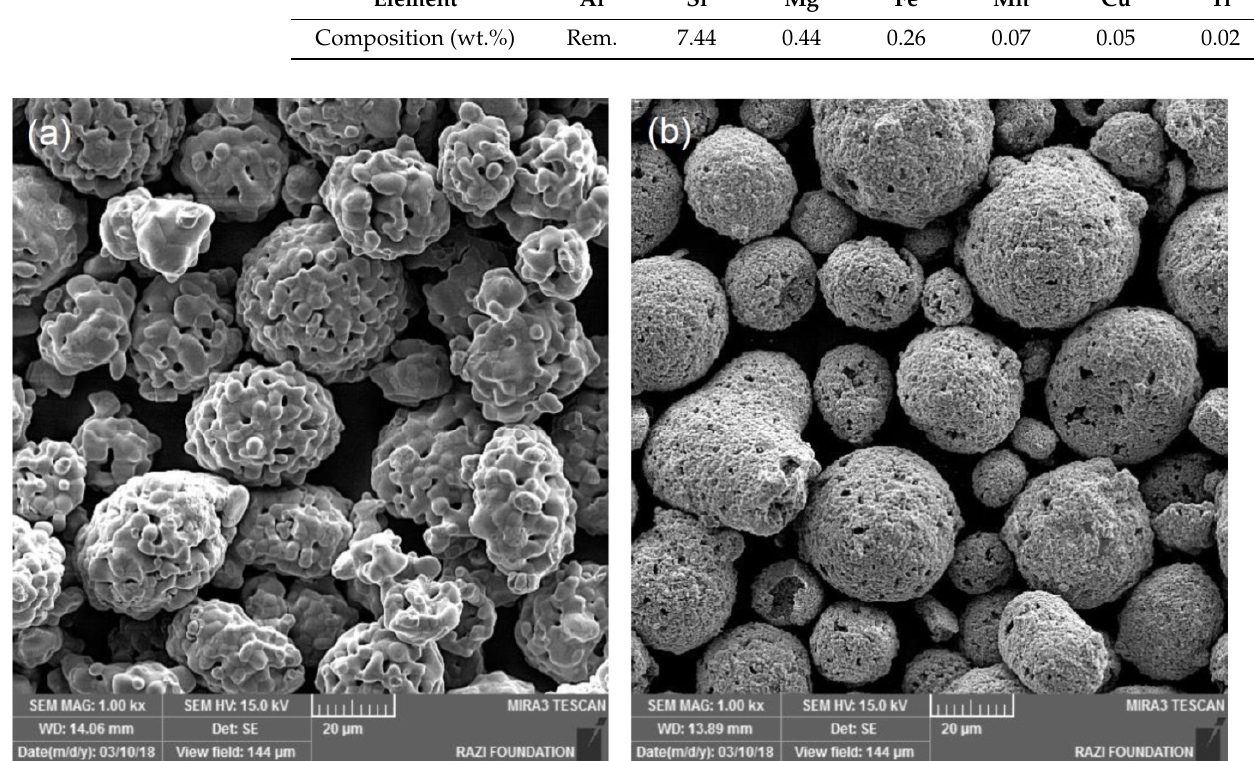
Figure 1. SEM micrograph of as-received ( a ) Cr 3 C 2 -NiCr and ( b ) WC-Co-Cr